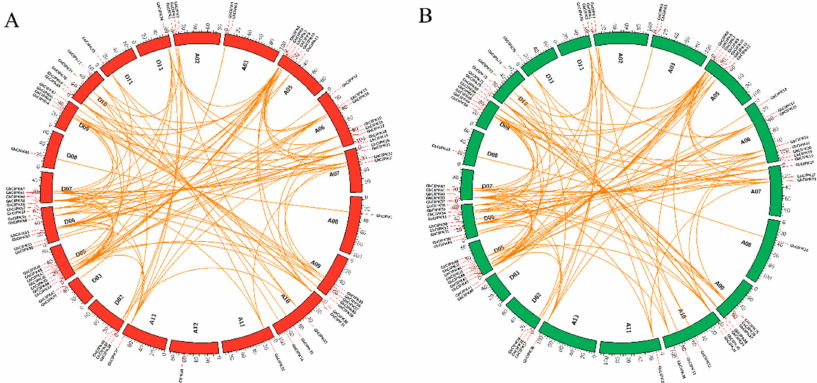
Figure 3. Genomic localization and gene duplication of CIPK genes in G. hirsutum and G. barbadense . ( A ) Genomic localization and gene duplication of CIPK genes in G. hirsutum ; ( B ) Genomic localization and gene duplication of CIPK genes in G. barbadense . Each of the duplicated gene pairs in GhCIPKs and GbCIPKs is connected with orange color lines. Chromosomes in G. hirsutum and G. barbadense are marked with red and green,